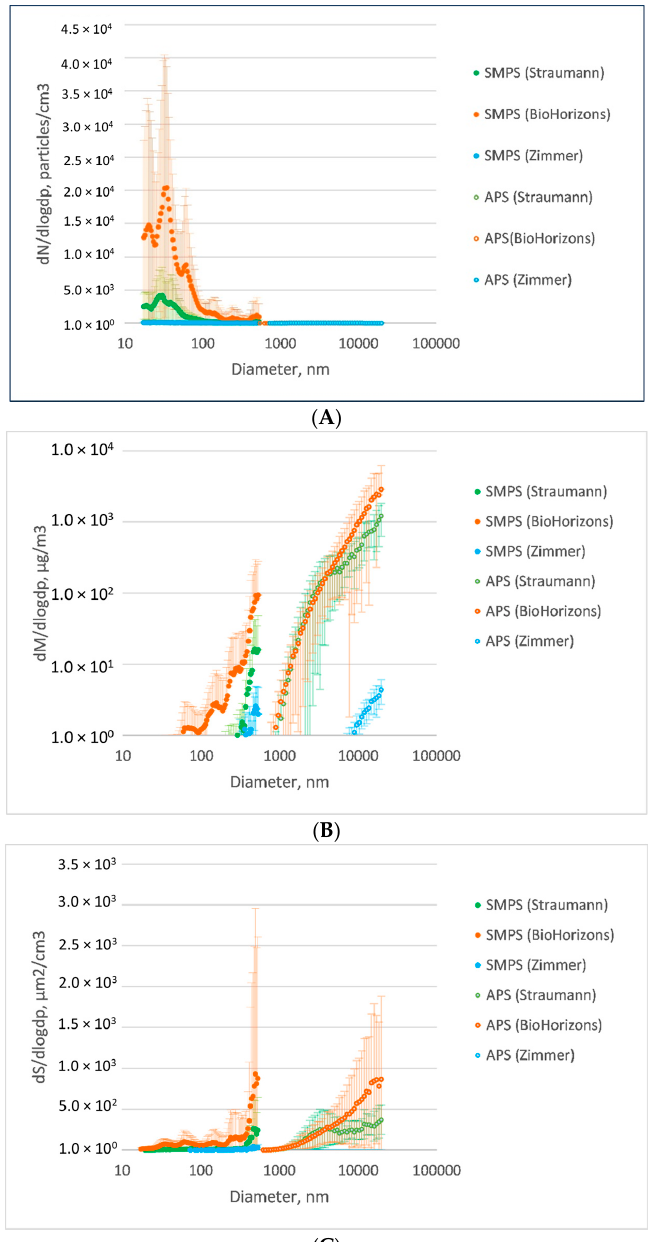
Figure 3. ( A ) Particle number concentrations distributed by size among groups. The highest particle number concentration was observed in Group B (BioHorizons); the lowest particle number concen- tration was in Group C (Zimmer), in both fine and ultrafine modes (<1 µm). For coarse particles (>1 µm), the particle number concentrations were more overlapped among groups. ( B ) Particle mass concentrations distributed by size among groups. The highest concentration of particle mass was observed in Group B (BioHorizons) and the lowest in Group C (Zimmer), in both fine and ultrafine modes (<1 µm). For coarse particles (>1 µm), Group A (Straumann) and Group B (BioHorizons) showed higher concentrations than Group C (Zimmer). ( C ) Particle surface area distributed by size among groups. The highest concentration of particle surface area was shown in Group B (BioHori- zons) and the lowest in Group C (Zimmer), in both fine and ultrafine modes (<1 µ m). For coarse particles (>1 µ m), the difference was less significant. Green dots: Group A (Straumann); orange dots: Group B (BioHorizons); blue dots: Group C (Zimmer). Solid dots: data from SMPS; hollow dots: data from